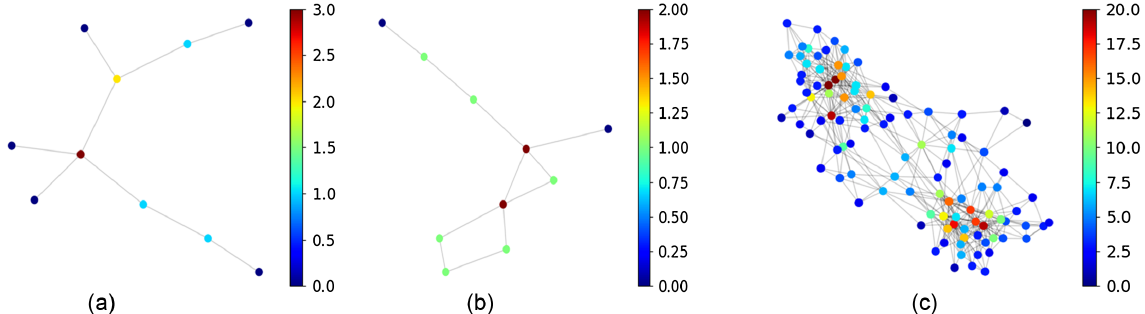
FIG. 1. Networks used for validation. (a) Toy tree network of 10 nodes. (b) Toy network with loops of 10 nodes. (c) Polbooks network [81] with 105 nodes. The color scale represents the degree of